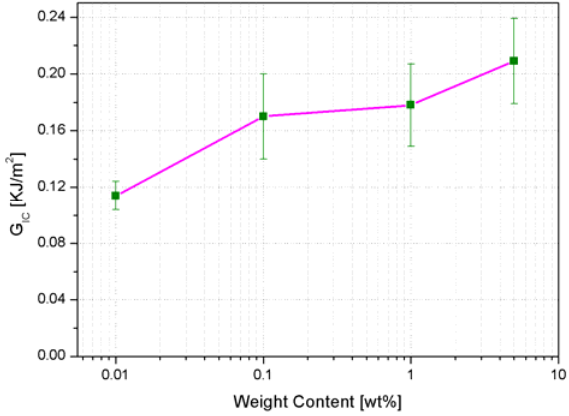
Figure 14. G IC results obtained from fracture toughness tests for neat and filled systems.